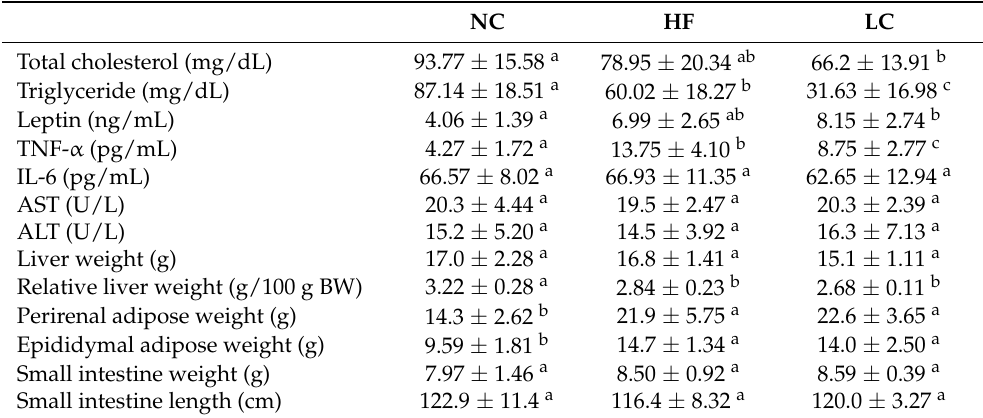
Table 3. Plasma biochemical parameters and organ weights in rats fed with the different experimental diets for 11 weeks.